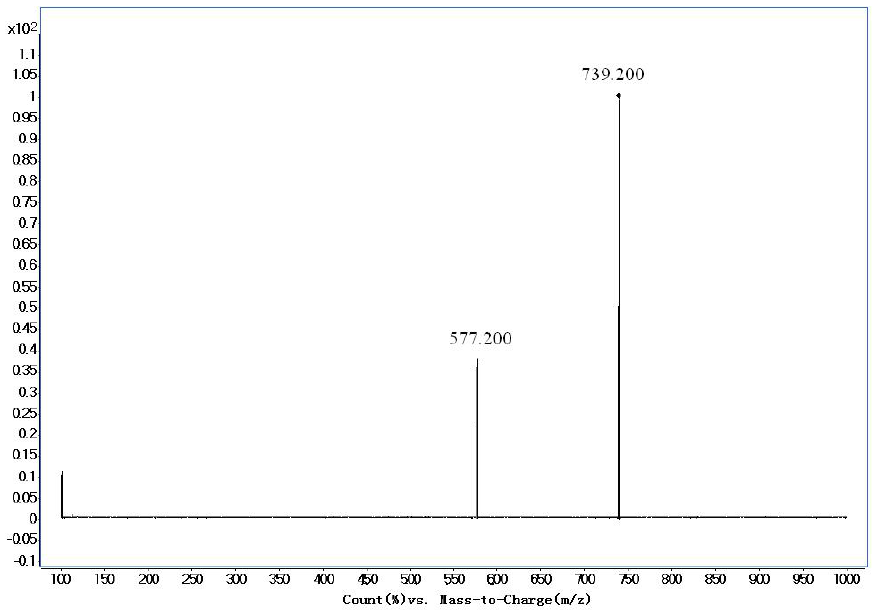
Figure 2. Production spectra of Timosapoin AIII.